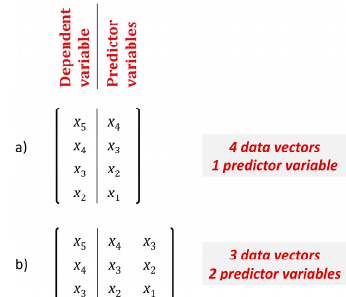
Figure 1. Sketch explaining how the training sample changes with the number of predictor variables